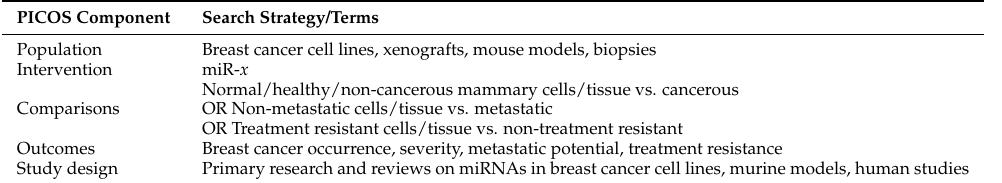
Table 3. Breast cancer PICOS search strategy as applied in this